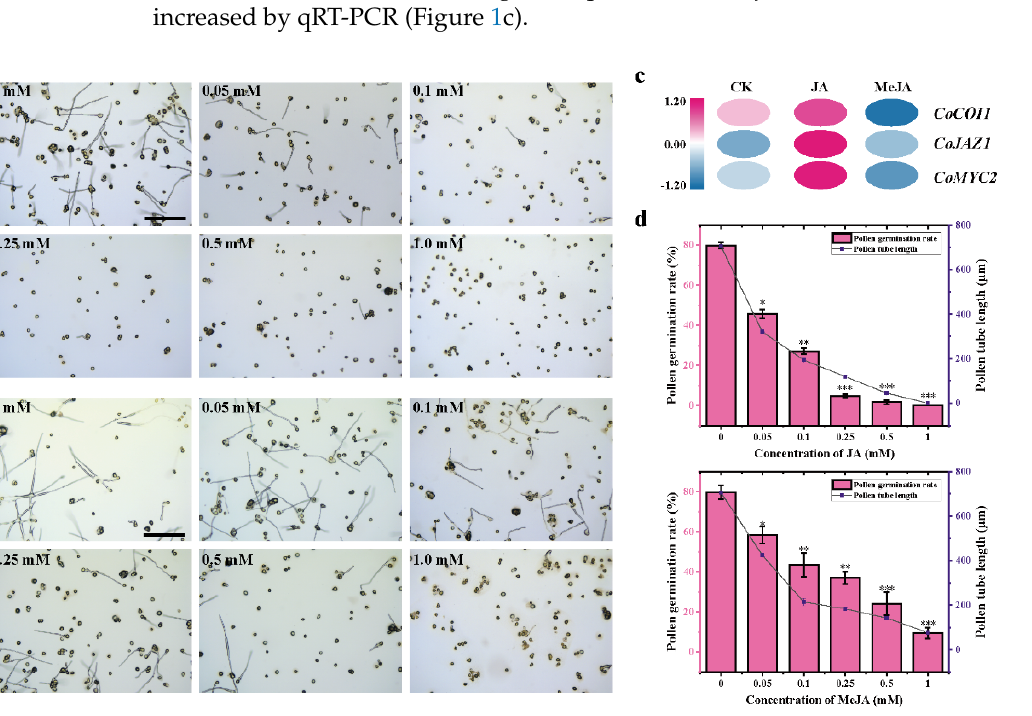
Figure 1. JA and MeJA affect pollen development of C. oleifera . ( a , b ) Pollen of C. oleifera was cultured with different concentrations of JA and MeJA. Bar = 500 μ m. ( c ) Expression of key genes about jasmonic acid-signalling module in C. oleifera pollen. ( d ) Pollen germination rate and pollen tube length of C. oleifera . * p < 0.05; ** p < 0.01; *** p <